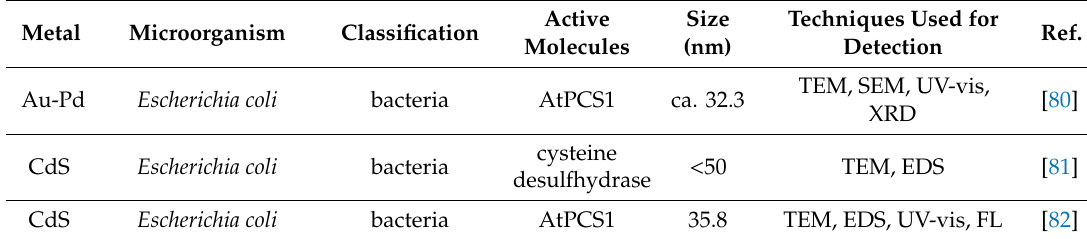
Table 6. List of genetically modified bacteria for synthesis of metal nanoparticles and technique for confirmation of metal nanoparticles.